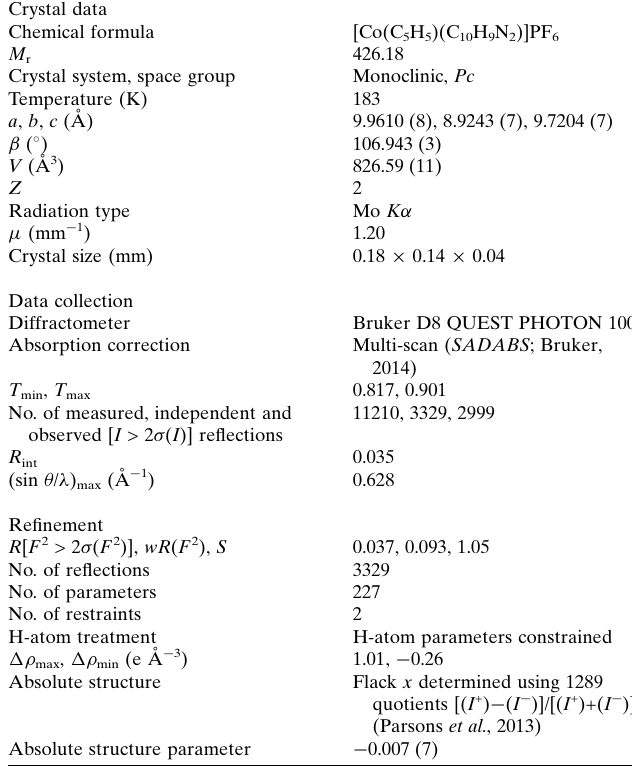
Table 2 Experimental details. Crystal data Chemical